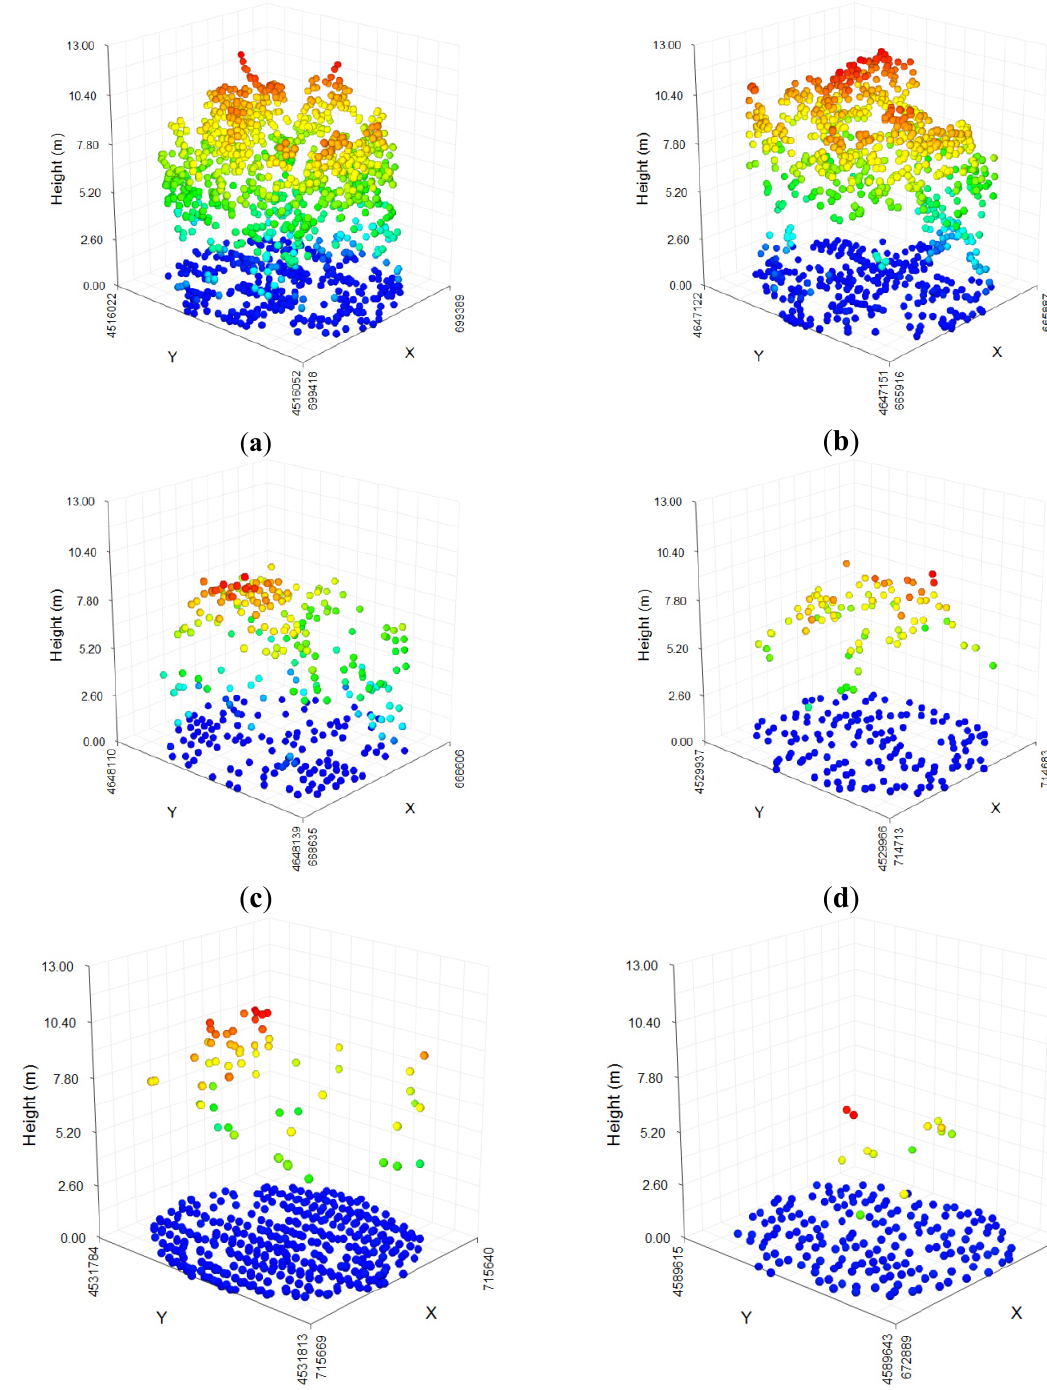
Figure 5. Examples of ALS point clouds at plot level and their correspondence with the CBI values. ( a ) CBI = 0.0; ( b ) CBI = 1.0; ( c ) CBI = 1.5; ( d ) CBI = 2.0; ( e ) CBI = 2.5; ( f ) CBI =